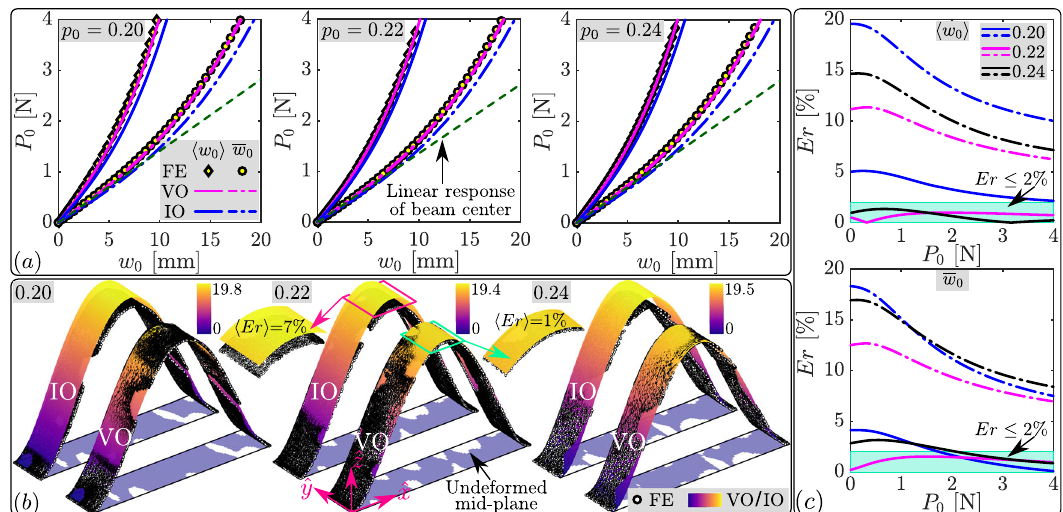
Fig. 3 Nonlinear static response of the porous beams. a All the beams are clamped at both ends and subject to a UDTL P 0 . Nonlinear responses obtained via three approaches (3D FE, VO, and IO) are compared in terms of the average transverse displacement ( 〈 w 0 〉 ) and the transverse displacement of the center of the beam ð w 0 Þ . The linear response of the center of the beam (dashed dark-green line) is provided to highlight the impact of geometric nonlinearity on the response of the beam. The linear response is simulated by ignoring the nonlinear term h i u m D α ð x Þ u m D α ð x Þ within the de fi nition of the 3D VO strain tensor in Equation (5). b Deformed mid-planes obtained from the VO and IO models x i x j are compared against FE results for P 0 = 4N. Spatial variation of the transverse displacement is illustrated on the deformed planes via color maps. The insets for p 0 = 0.22 highlight the error in the region x × y = [0.4, 0.6] L × [0, b ]. c Relative error in the predictions of the VO (solid line) and IO (dashed line) models with respect to the FE results (considered as ground truth).